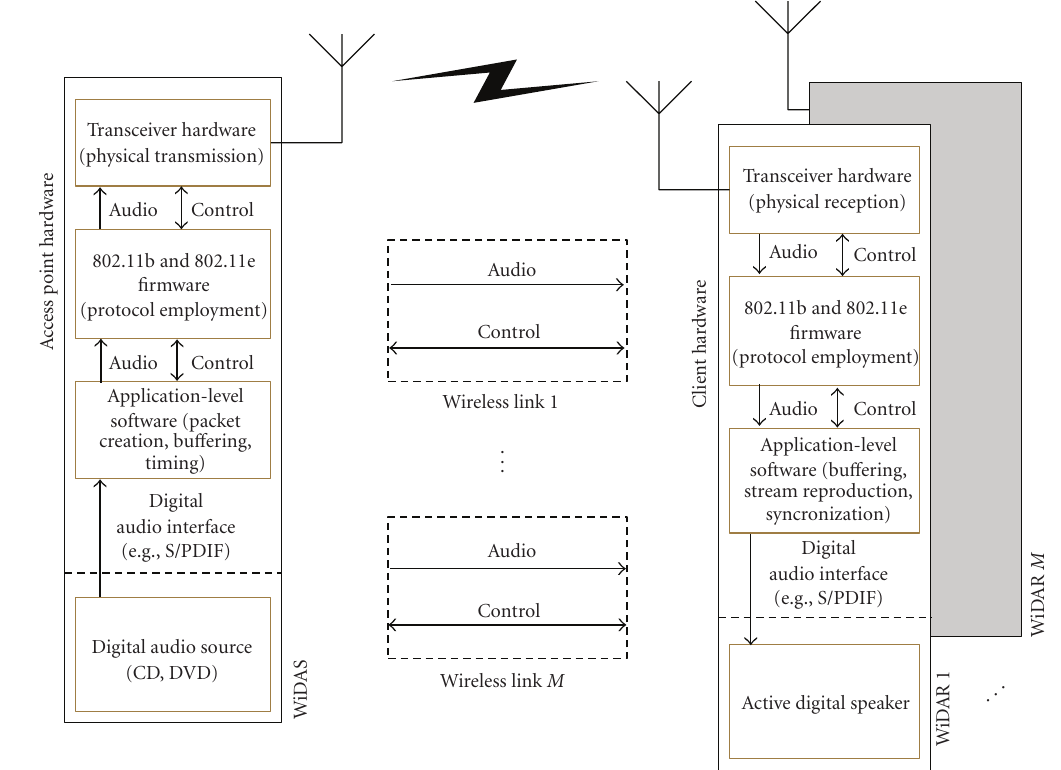
Figure 2: Architecture of the WLAN multichannel playback system considered in the